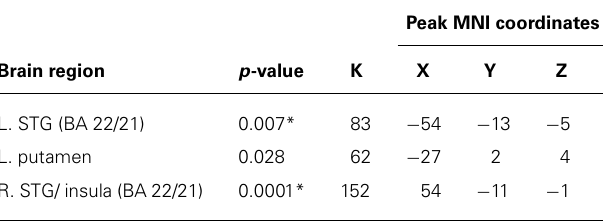
Table 2 | RV > IV PPI-contrast for a ROI seed in the LIFG (BA 44, LIFGop3).